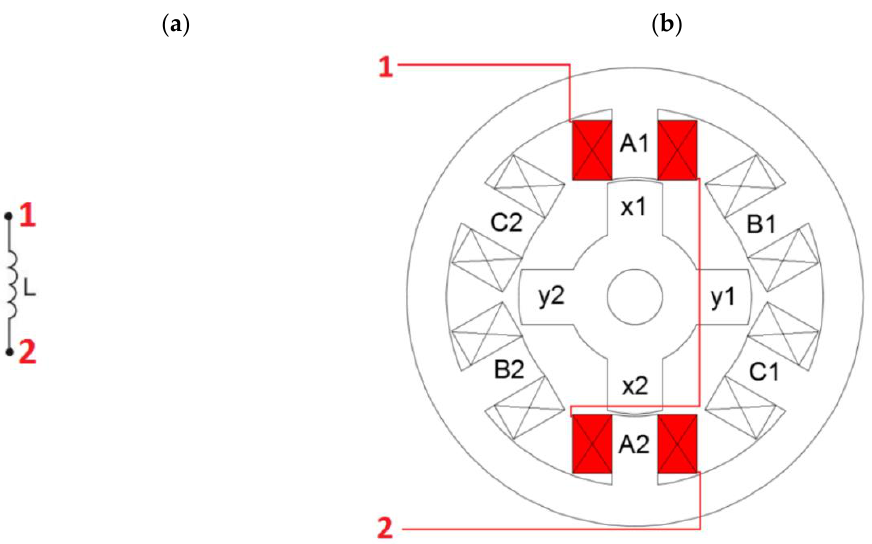
Figure 9. Simple schematic showing switched reluctance motor winding: ( a ) Symbol of winding, L . ( b ) A simplified diagram of the phase winding of an SRM motor. A single motor cycle for one of the phase bands consists of four stages. Those stages are described in Table 1 below.